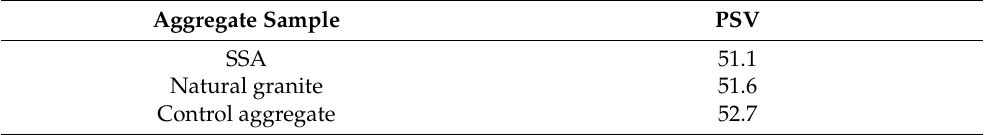
Table 2. Polishing stone values (PSV) of the studied aggregates.